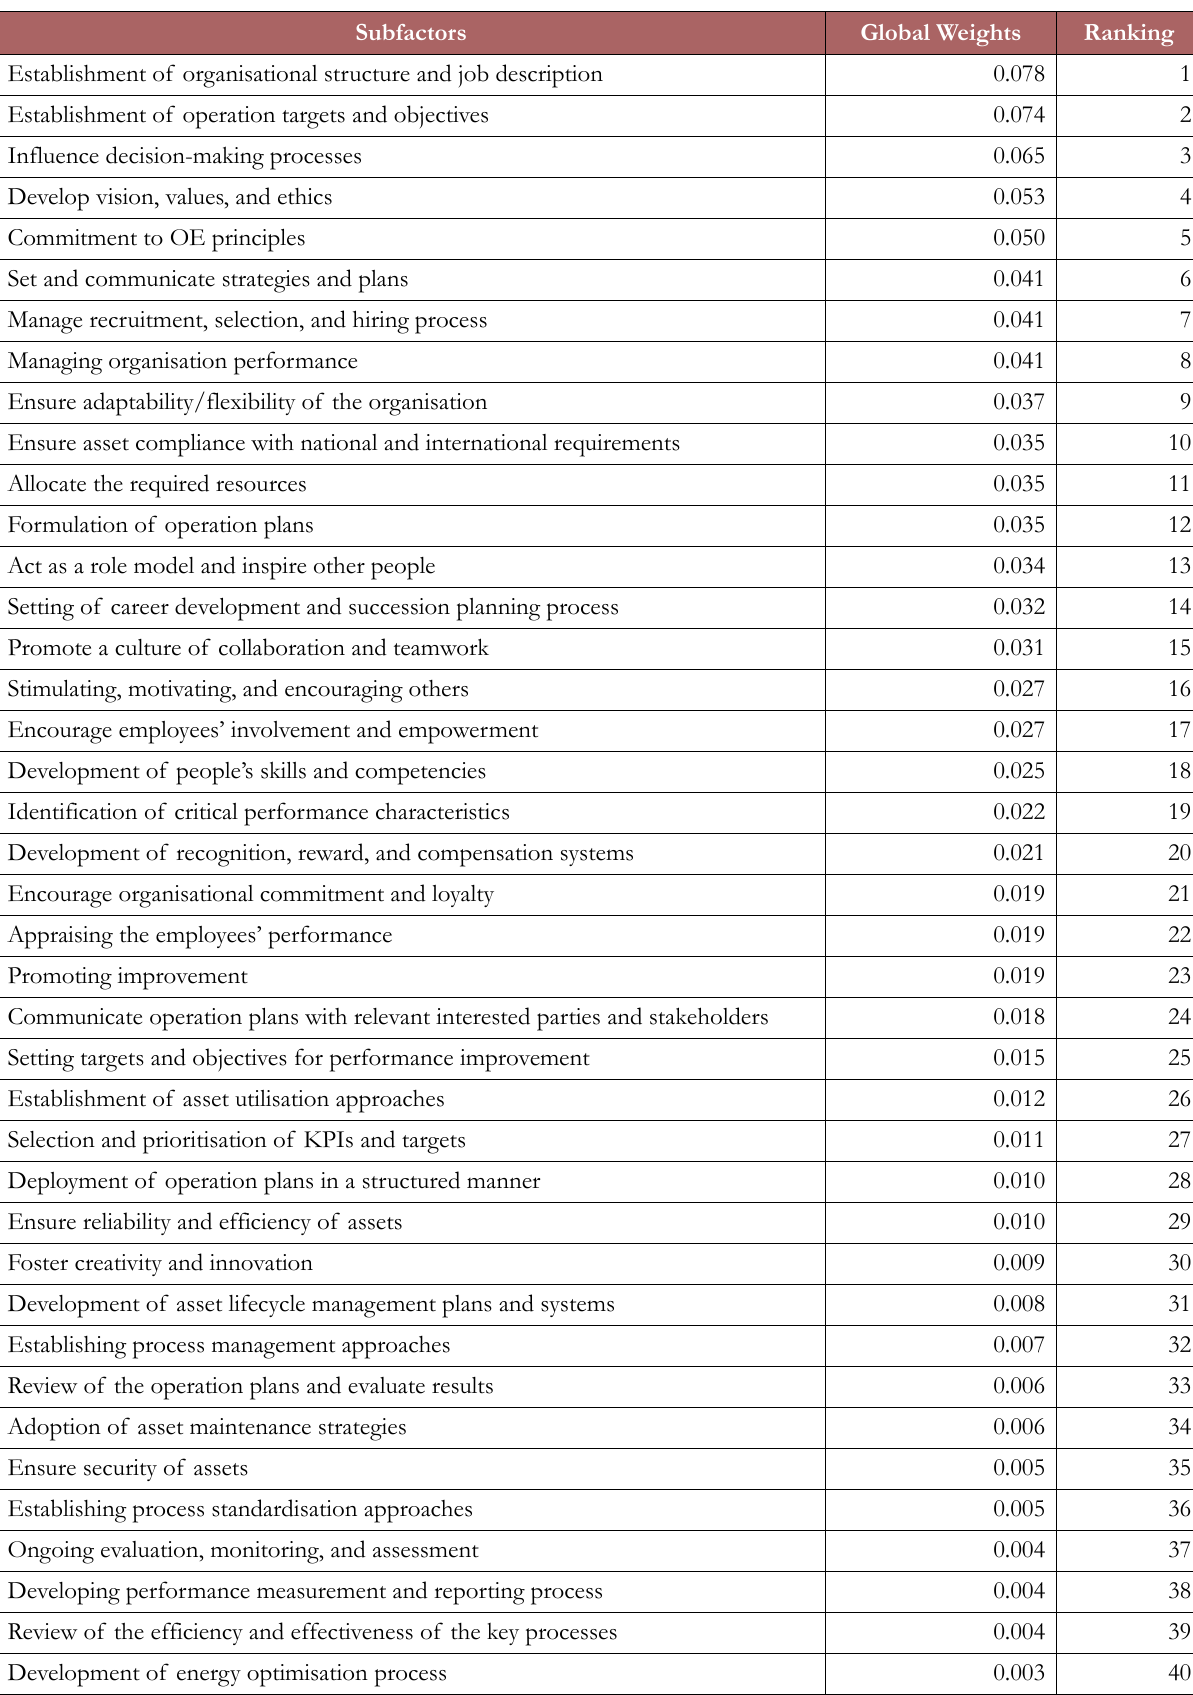
Table 8. The Ranking of the Subfactors Based on the Global